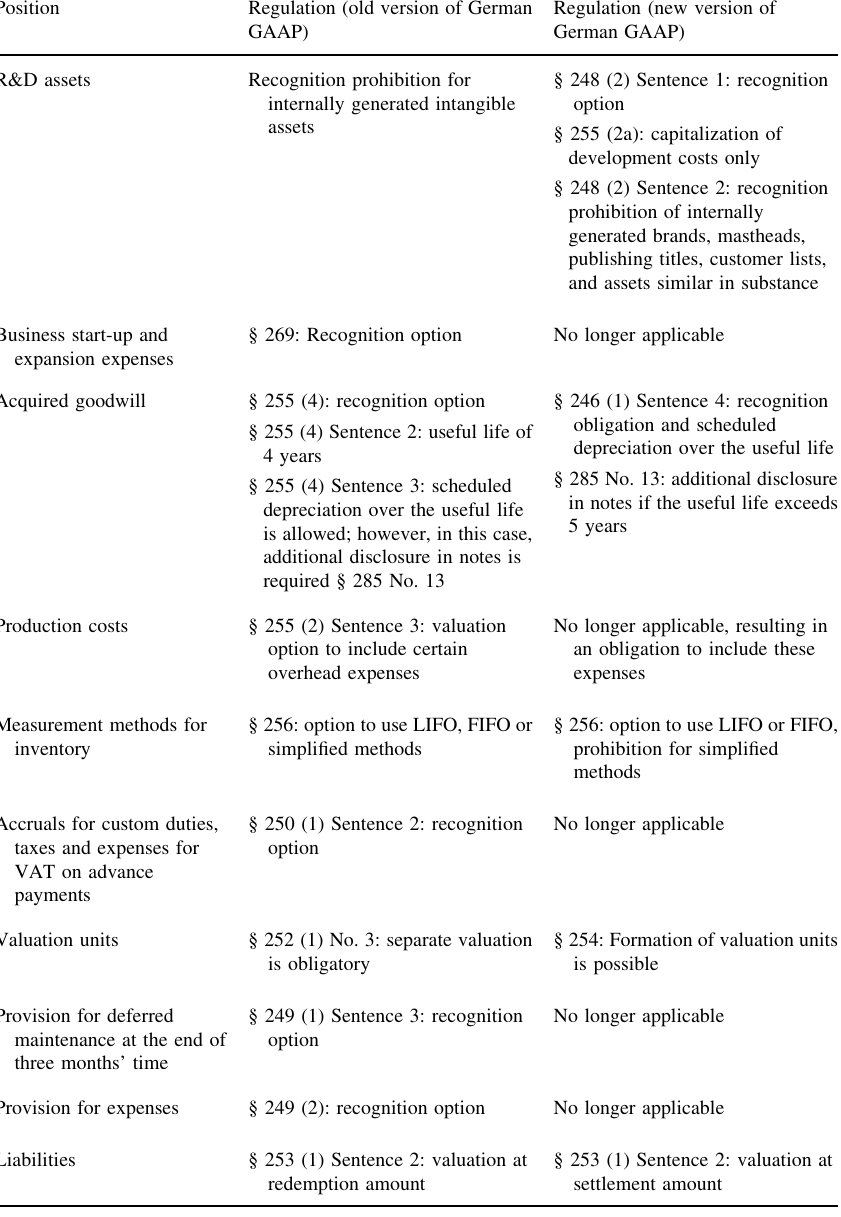
Table 1 A summary of the main changes in German GAAP under the German Accounting Law Modernization Act